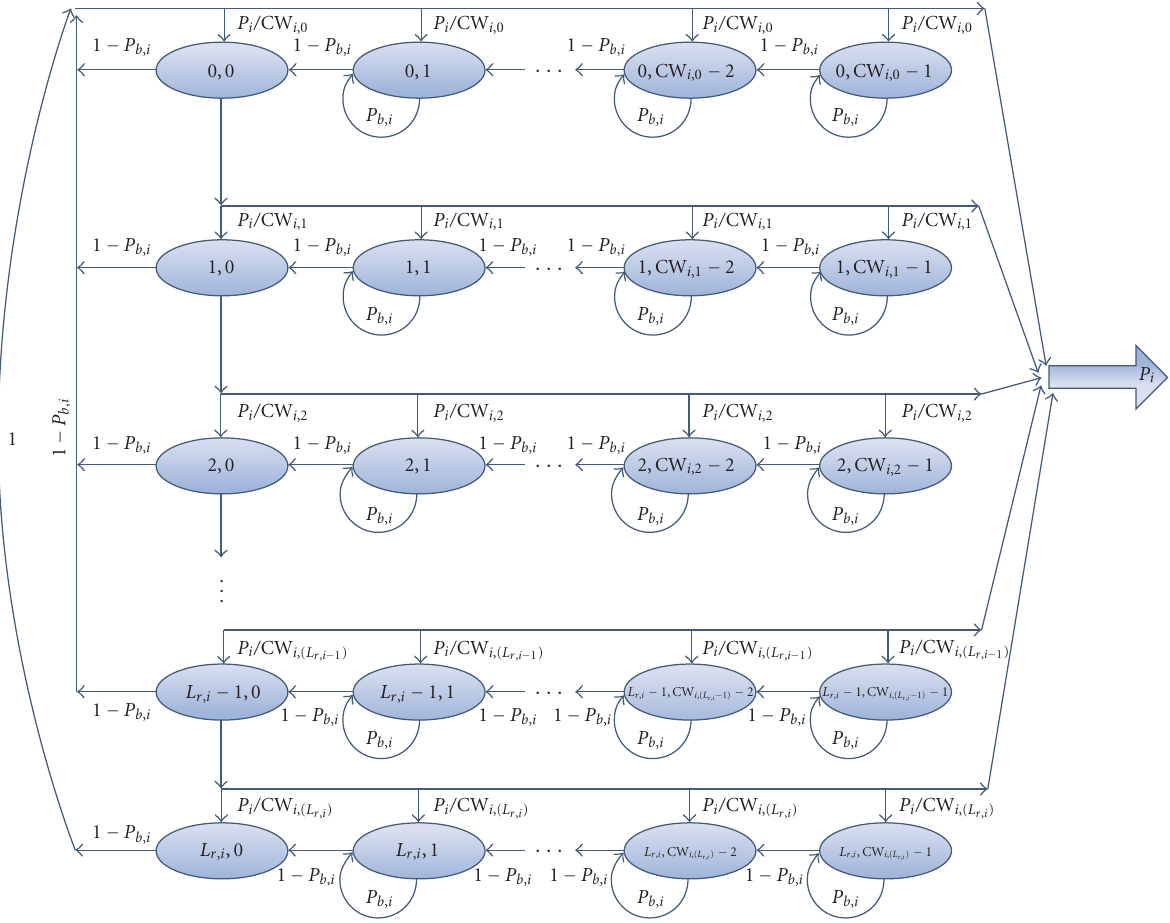
Figure 1: This diagram is a modified Markovian chain summarizing the back-o ff procedure in 802.11e